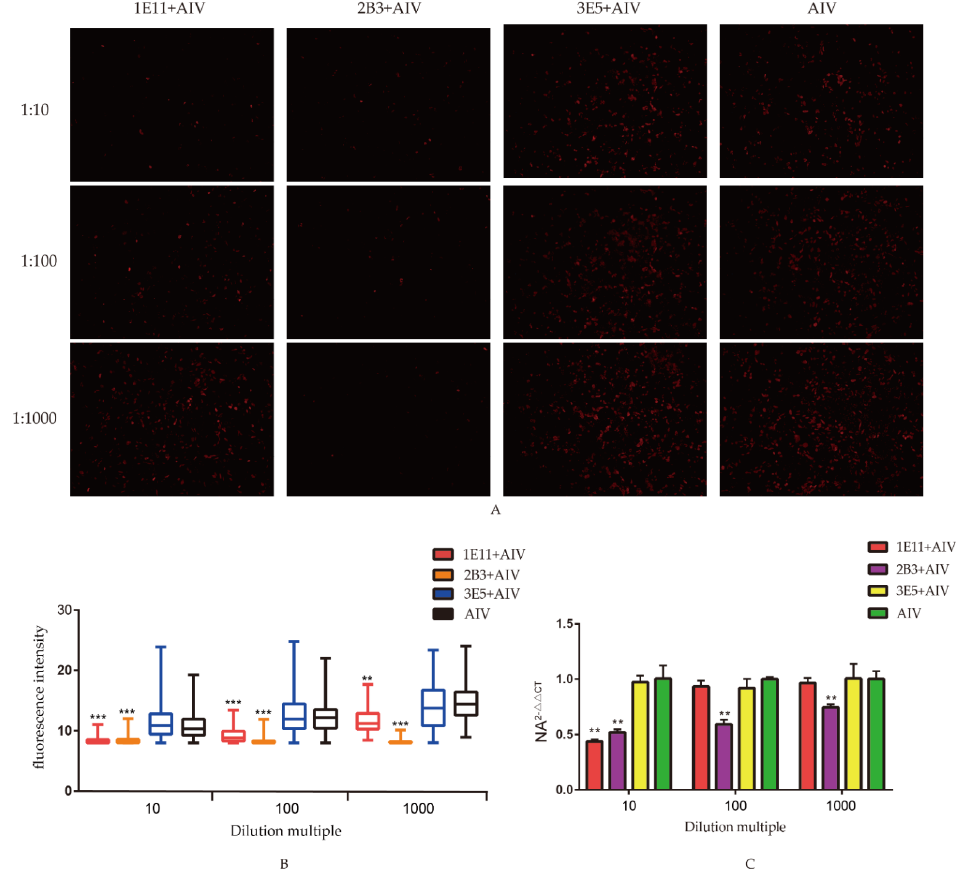
Figure 4. Neutralization assay: ( A ) neutralization effect of the screen mAbs. AIV were co-incubated with three mAbs and infected MDCK cells for 36 h. AIV proliferation in cells was analyzed by the indirect immunofluorescence to analyze the neutralization effect of mAbs; ( B ) the fluorescence intensity in the infected MDCK cells. The software ImageJ was used to quantify the fluorescence intensity of the indirect immunofluorescence images, and the data were represented in Graphpad for the differential analysis; and ( C ) the mRNA levels of NA in MDCK cells. Cells and supernatant total RNA were extracted for real-time fluorescent quantitative PCR, followed by differential analysis using Graphpad. All data were presented as mean ± SD. * p < 0.05, ** p < 0.01, and *** p < 0.001.